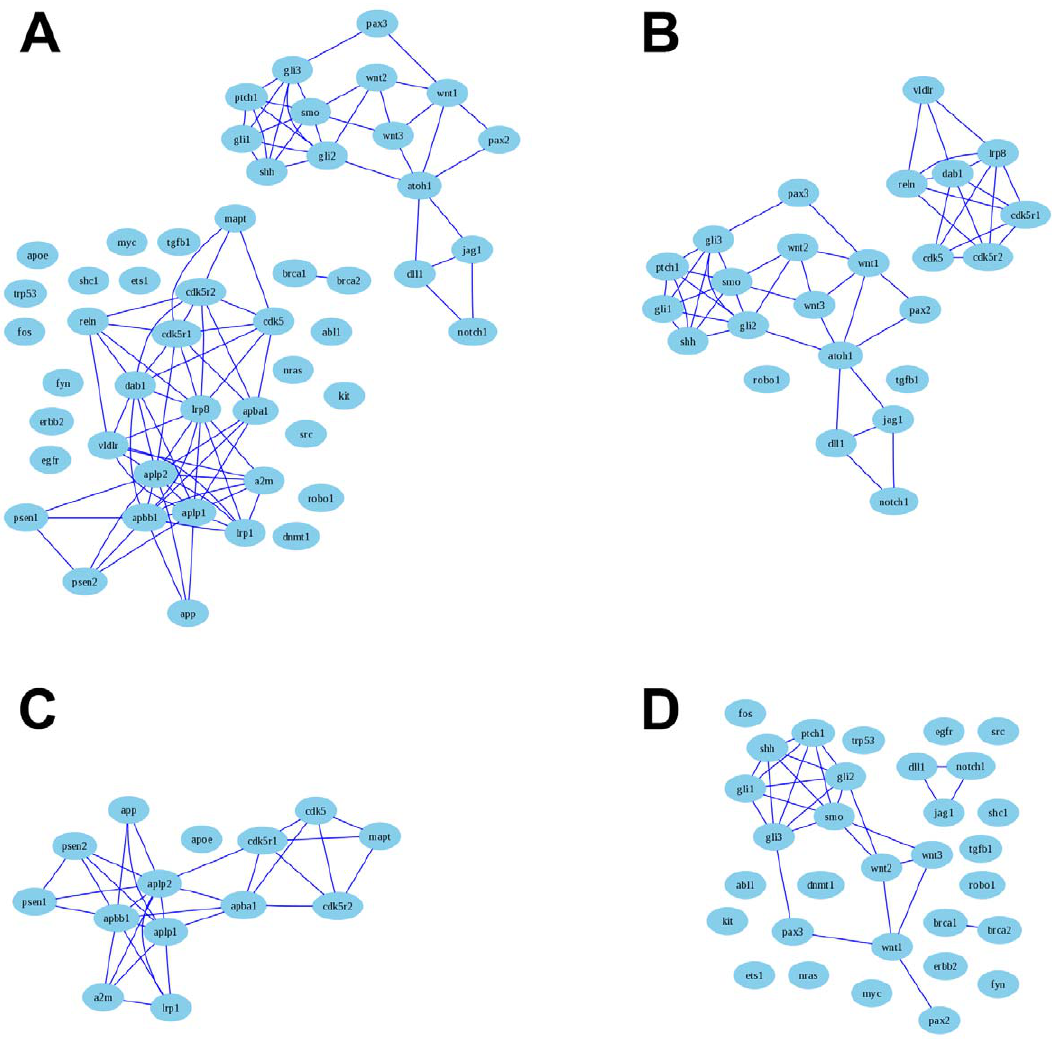
Figure 5. A network graph representation of literature relationships among 50 manually selected genes (A). Graphs are also displayed for functional categories: development (B), Alzheimer’s disease (C) and cancer (D) as described previously in [14]. Nodes in the graphs represent individual genes and the edge threshold is a cosine of 0.6, which represents approximately 5% of all edges in the collection.